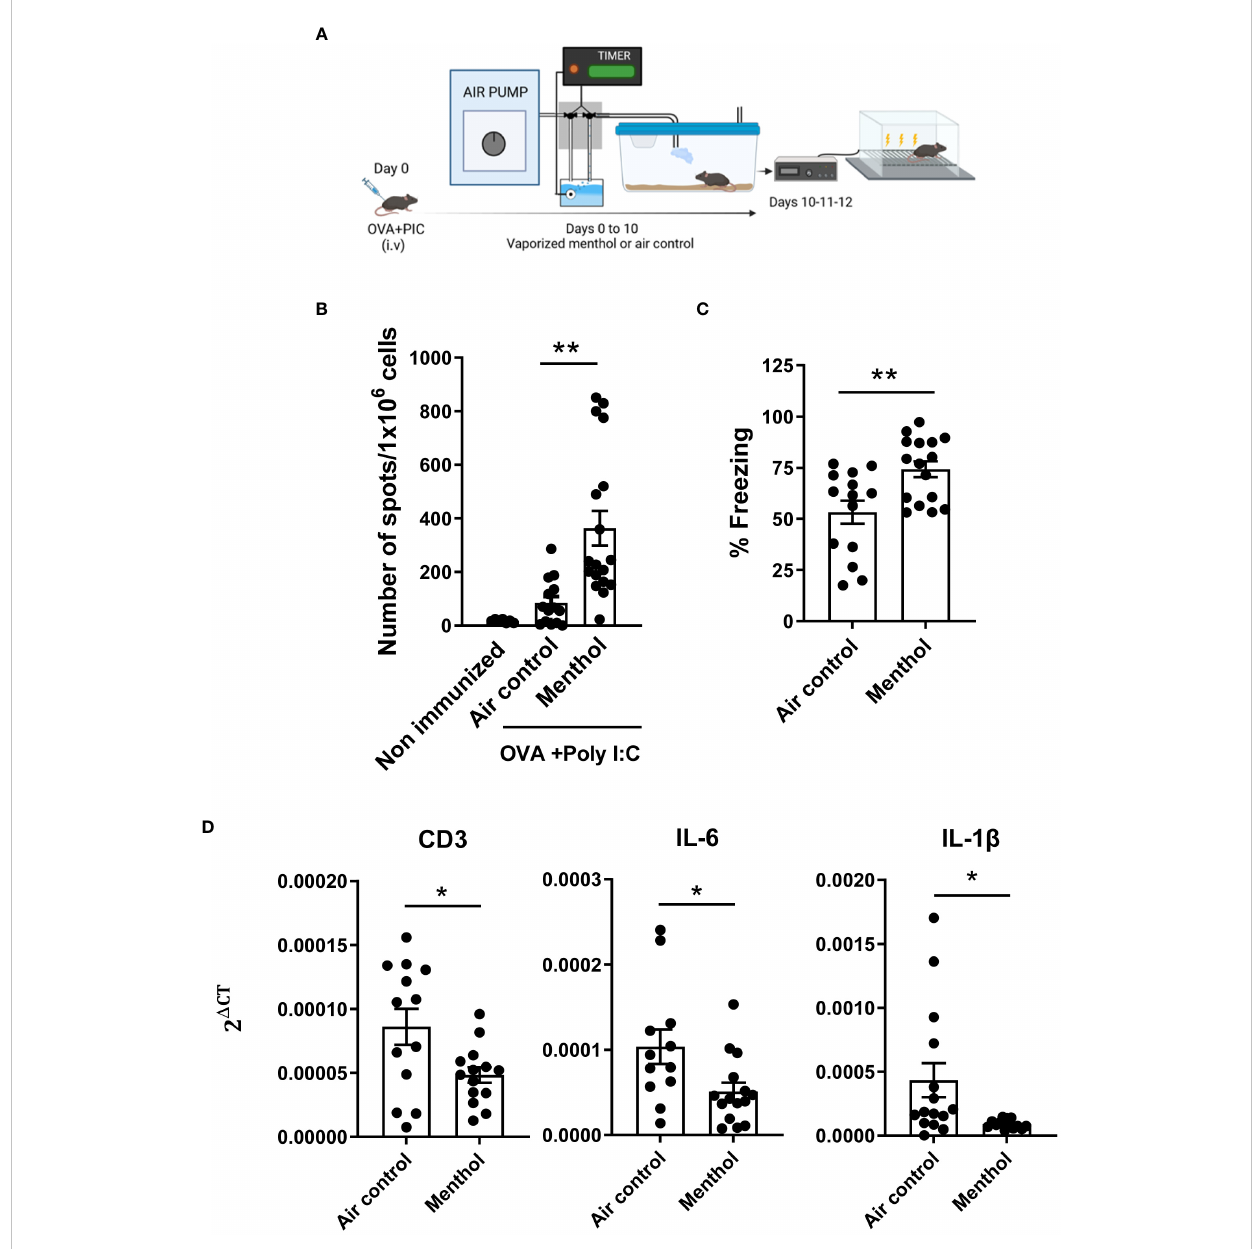
FIGURE 1 Effect of menthol inhalation in the immune response against ovalbumin immunization and on the cognitive capacity. (A) Schematic depicting the experimental procedure. Mice were immunized with OVA+ poly I:C and exposed to vaporized menthol or water vapor as control (Air control), for 7 days. (B) IFN- g producing cells speci fi c for SIINFEKL peptide were measured by ELISPOT. (C) Fear learning and memory were evaluated using a classic fear-conditioning assay. (D) mRNA for CD3, IL-1 b or IL-6 was measured in mRNA samples obtained from prefrontal cortex of the indicated groups of mice. Data analyzed with student ’ s t-test. **p<0.01,